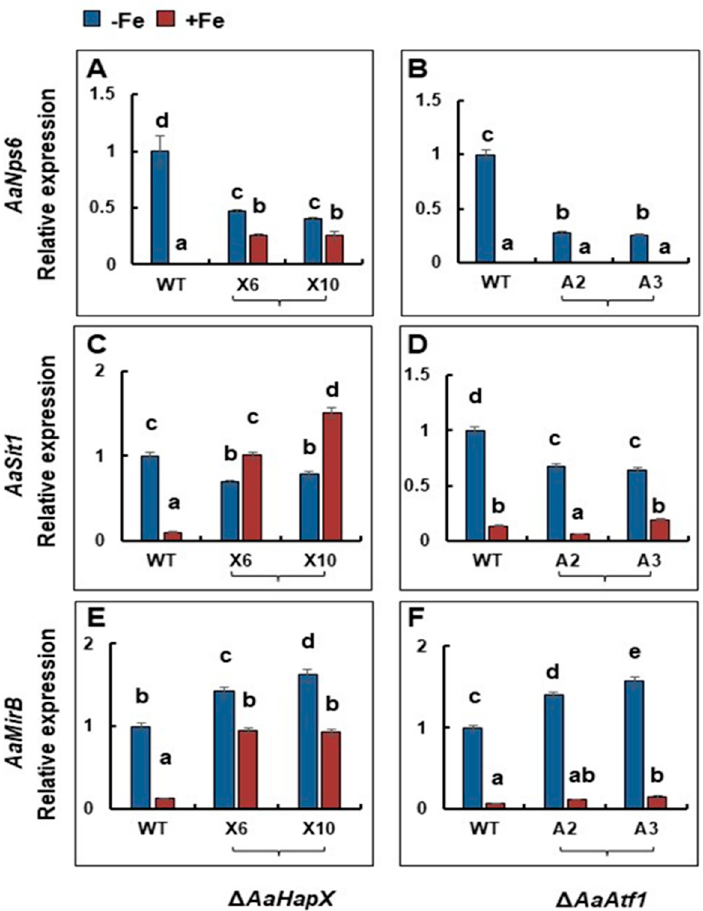
Figure 5. Quantitative real-time PCR analyses of the expression of siderophore biosynthesis- and transport-related genes in A. alternata strains grown in the presence or absence of iron. Wild type, ∆ AaHapX (X6 and X10), and ∆ AaAtf1 (A2 and A3) were grown in PDB at 28 °C for 2 to 3 days. Mycelium was harvested, washed with water, transferred into liquid MM or MM amended with 0.2 mM FeCl 3 , and incubated for an additional 24 h. RNA was purified from mycelium and used for first-strand cDNA synthesis. Quantitative RT-PCR was performed using primers targeting AaNps6 ( A , B ), AaSit1 ( C , D ), or AaMirB ( E , F ). The relative expression level from three independent reactions was calculated by a comparative Ct method ( ∆∆ CT) in relation to the expression of the fungal β -tubulin-coding gene. In each assay, the expression level in the wild type grown in MM was set to 1. Means indicated by the same letter are not significantly different, p < 0.05. All experiments were repeated at least two times, showing similar trends.